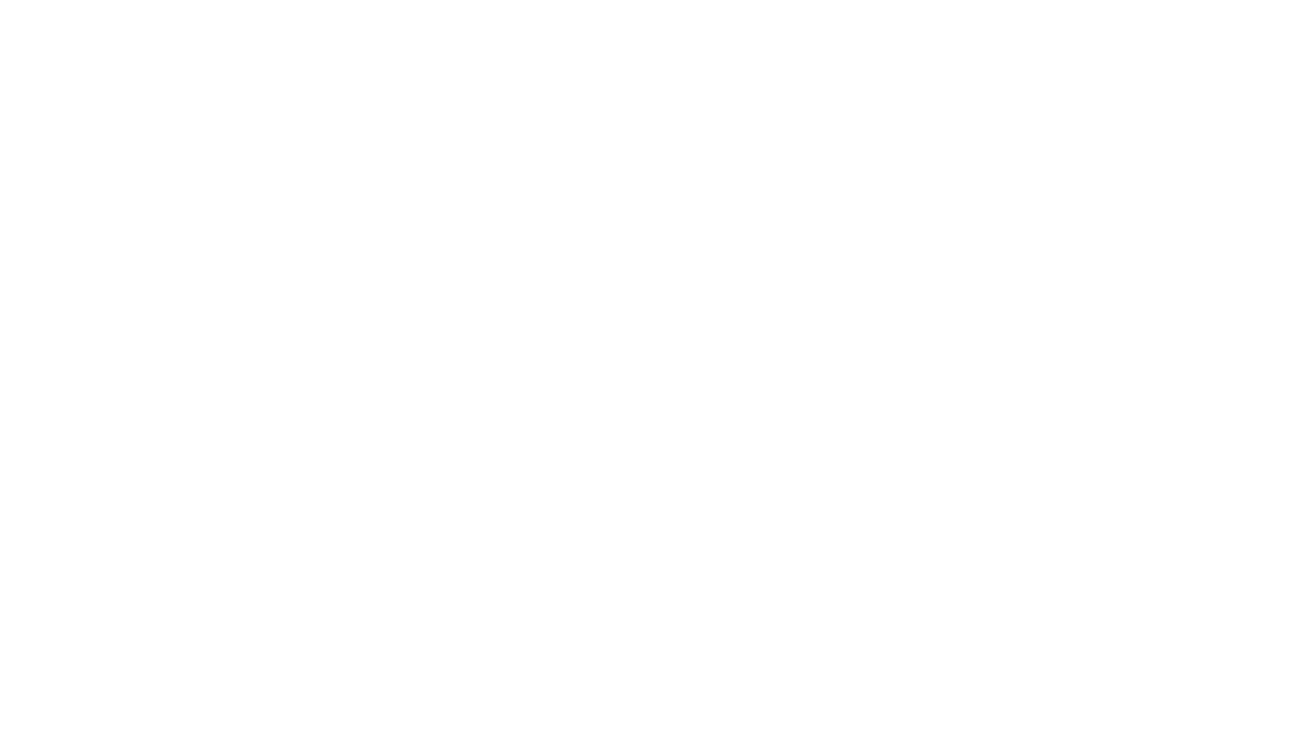
FIGUREA2 | Scrubbing timepoints containing micromovements from each participants’ resting state timeseries had limited impact on our results. This figure shows the surface plots for each effect of interest for analyses using data without scrubbing (as reported in our manuscript) and analyses using scrubbed